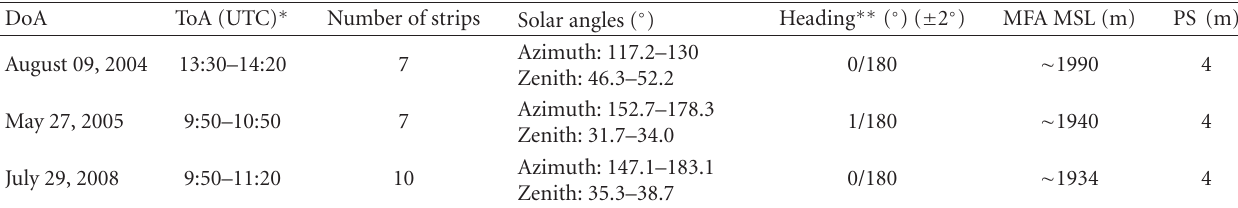
Table 1: Characteristics of available HyMap data sets and its acquisition